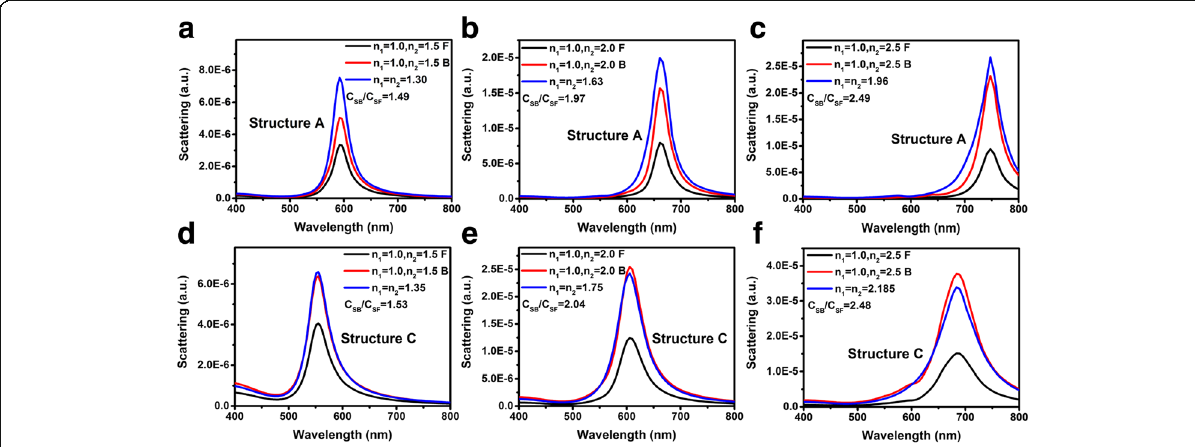
Fig. 4 Scattering spectra for varying n 2 = 1.5, 2.0, and 2.5 of structure A ( a – c ) and structure C ( d – f ) respectively. Light is incident normally from air (denoted as black lines) and substrates (denoted as red lines). The blue lines show the scattering spectra of which the Au NPs are surrounded by infinite dielectric mediums with effective refractive